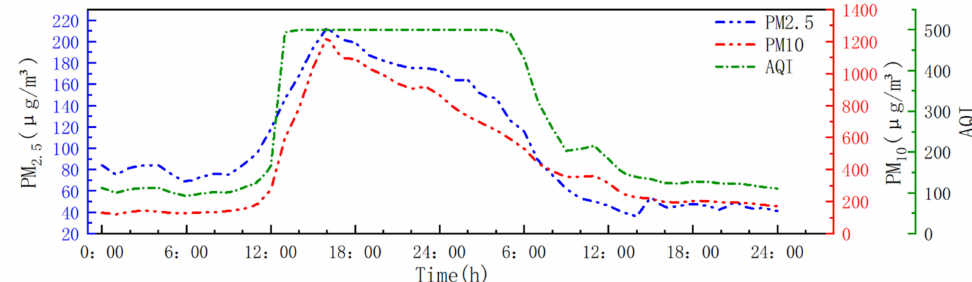
Figure 5. Changes in the PM2.5 and PM10 concentrations with time.